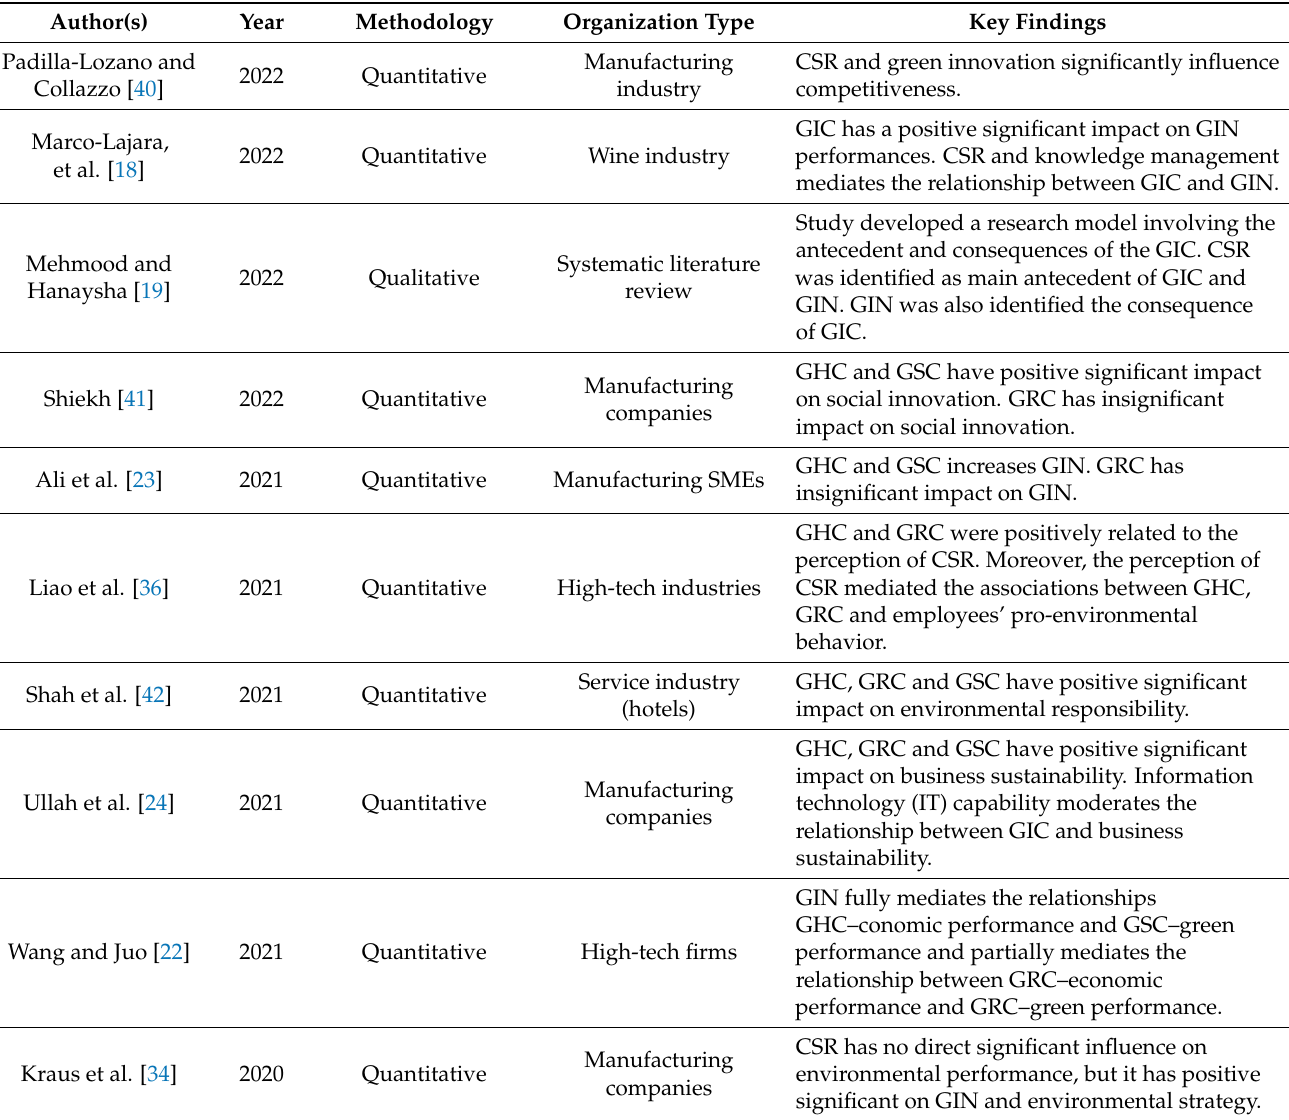
Table 1. Key findings of related